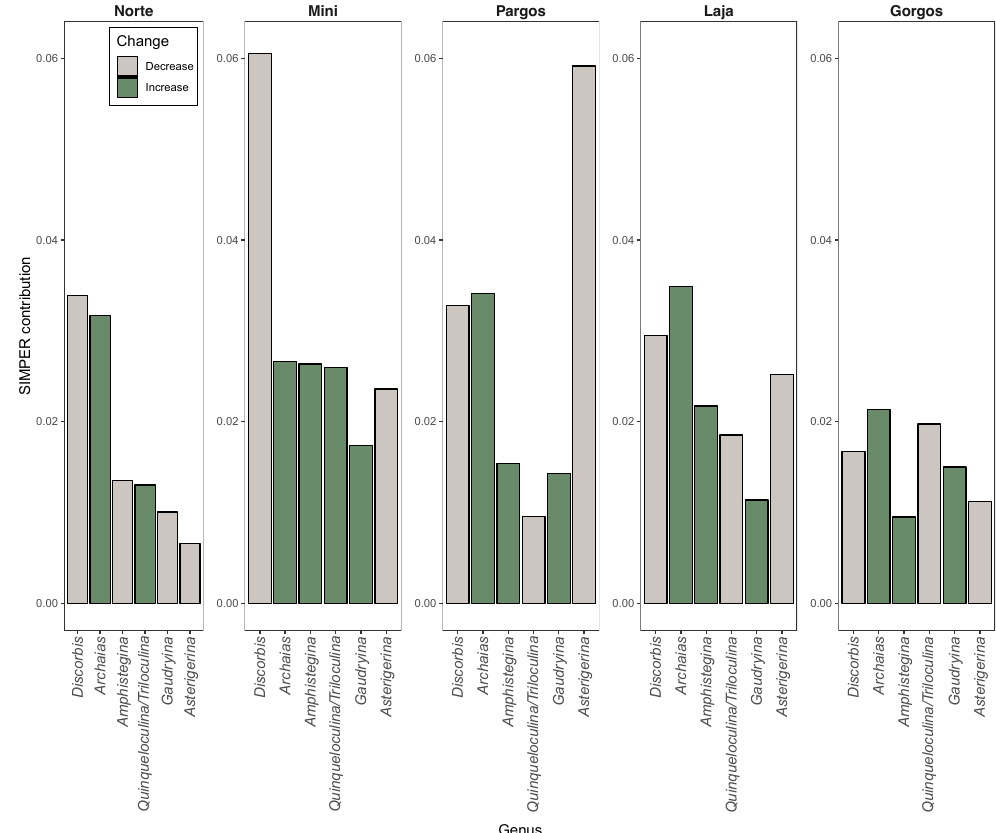
Figure 3. SIMPER contribution of the most abundant genera. Bar height indicates the mean contribution of each genus to community dissimilarity. Green color represents an increase and grey color represents a decrease in the mean relative abundance of each genus at low-saturation springs.